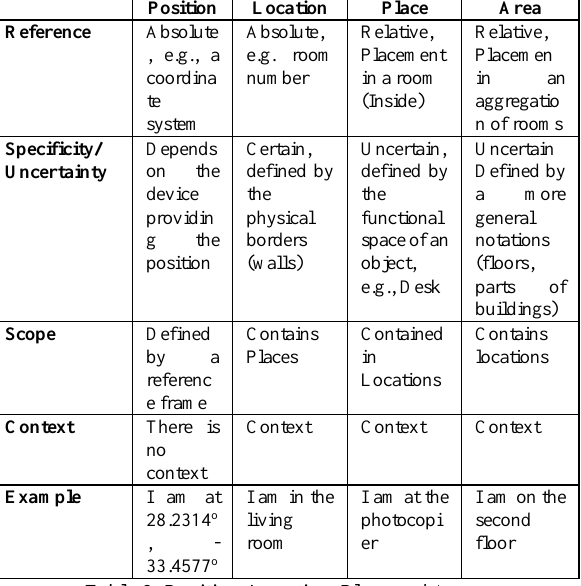
Table 3. Position, Location, Place and Area